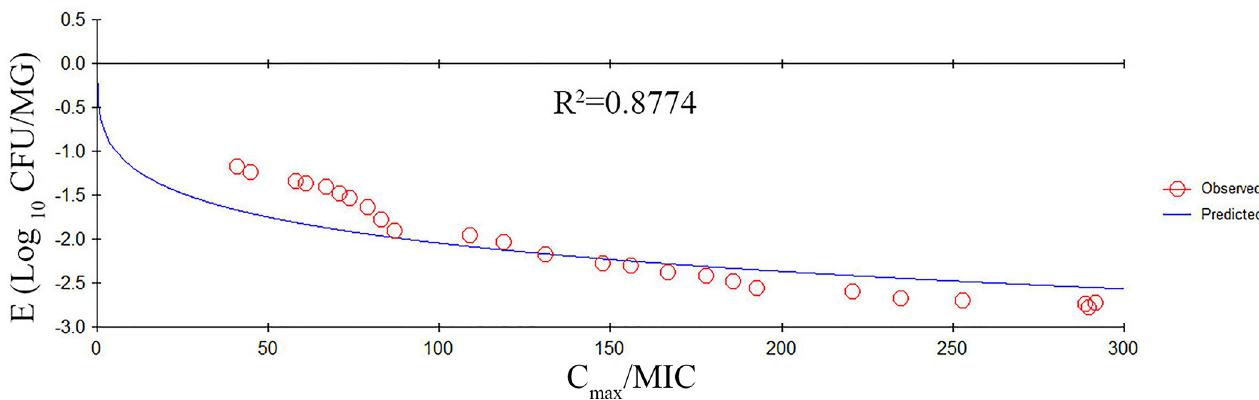
Fig 7. The inhibitory Sigmoid E max relationship between in vivo antibacterial effects ( 4 log CFU/MG) and the PK/PD index of C max /MIC against S . agalactiae 3–64. The line represents the fit of the model to the data. The circles represent the observed PD data. R 2 indicates the correlation coefficient.